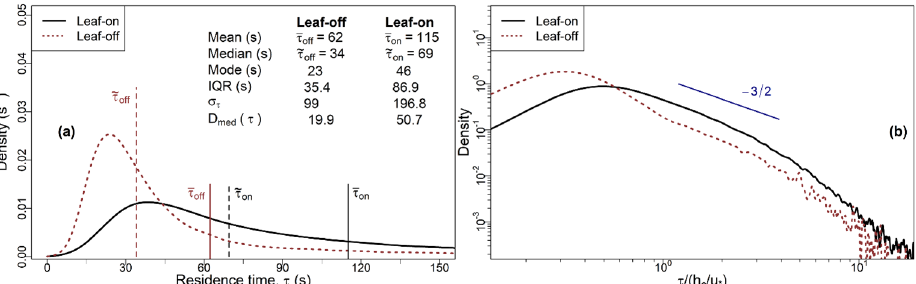
Figure 5. (a) PDFs and statistics of the residence times for the leaf-on and leaf-off periods (see Sect. 2.2 for observation details and Sect. 2.3 for calculations of the residence time, τ ). Solid and dashed vertical lines mark the mean and median values for each period, respectively. The mode for each period is taken as the value at which the PDFs attain their maximum densities. (b) As for (a) , with PDFs presented on log–log axes with τ normalised by the canopy turnover time, h c /u ∗ (Sect. 2.4). The black line is the same as in Fig. 3, although panel (a) presents dimensional information, whereas Fig. 3a presents the normalised